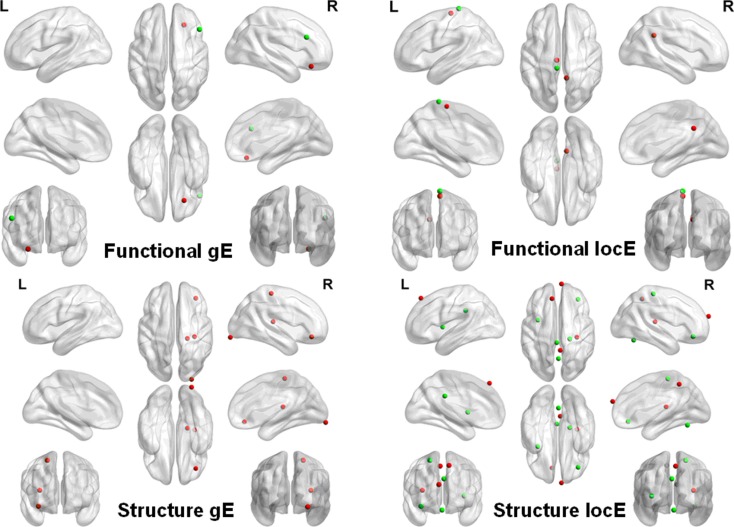
Network nodal efficiency difference between the PD and NC groups. L, the left hemisphere; R, the right hemisphere; gE, global efficiency; locE, local efficiency; red color indicates increased efficiency; and green color indicates decreased efficiency in PD patients.